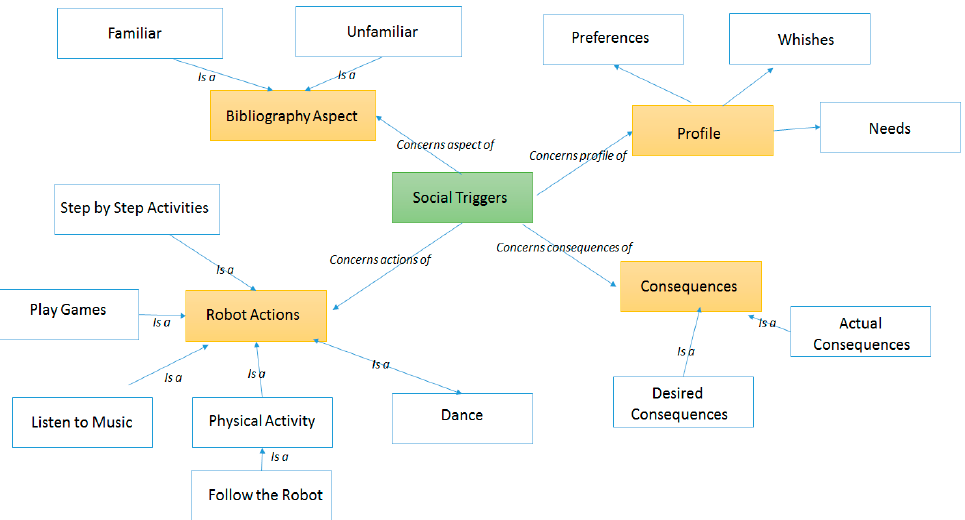
Figure 7. Proposed older adult–robot engagement and motivation ontology.